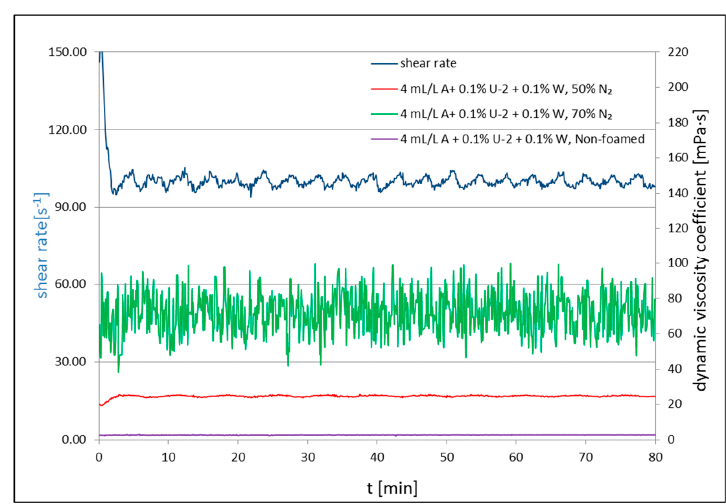
Figure 4. Viscosity of non-foamed and N 2 foamed fluid of 50% and 70% quality at 23 ◦ C at a shear rate of 100 s − 1 .